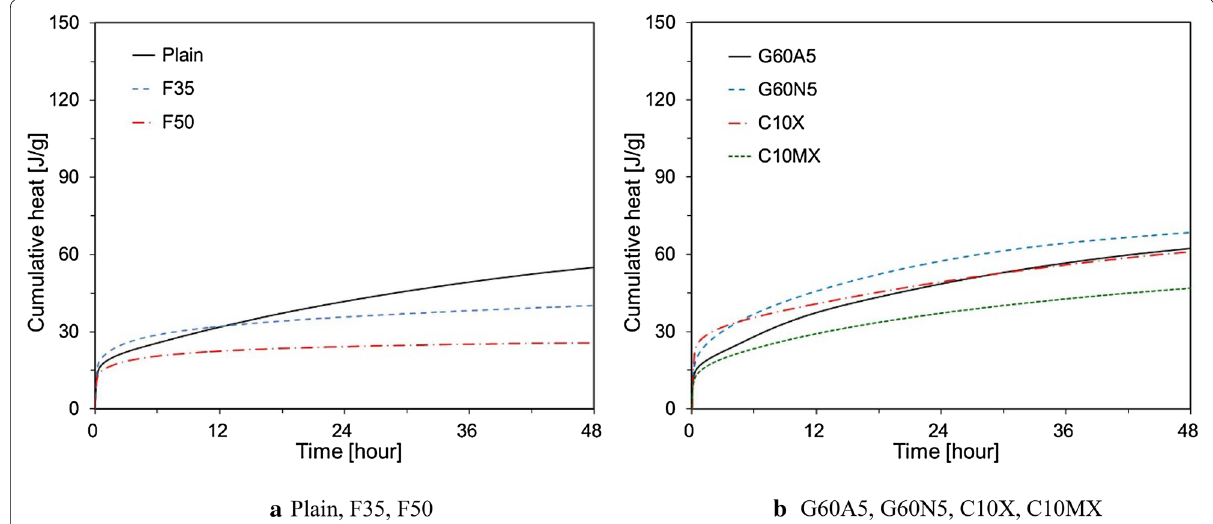
Fig. 9 Cumulative heat production after 91 days of curing.